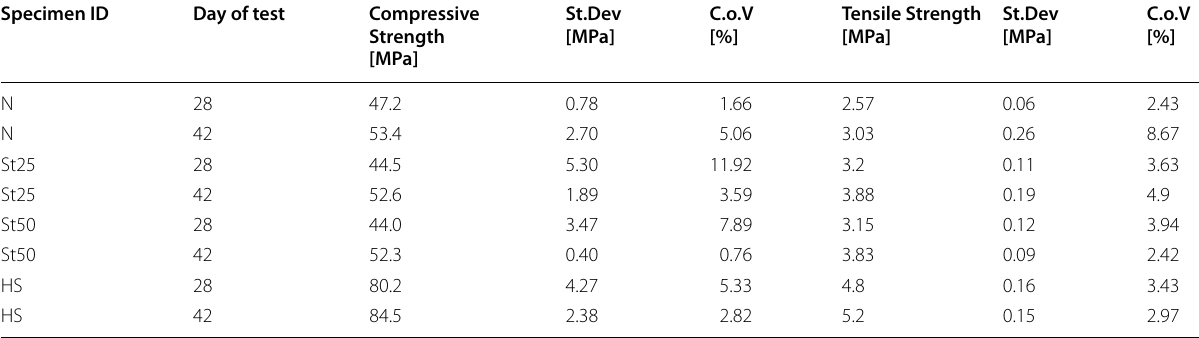
Table 3 Compressive and tensile strength of specimens at ambient temperature.